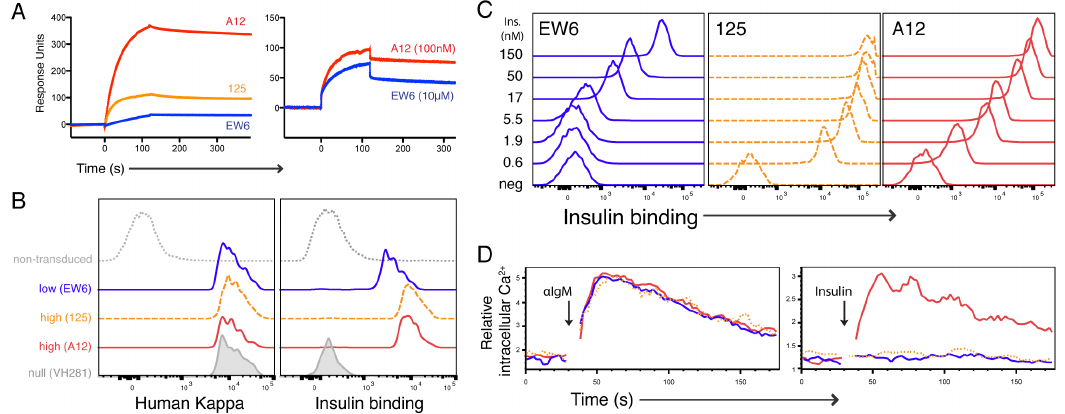
Figure 1. Light chain pairing with VH125 affects affinity for insulin. ( A ) SPR of recombinant Ig at 1 μ M insulin concentration (left); comparison of high ‐ affinity A12 binding 100 nM insulin and low ‐ affinity EW6 binding 10 μ M insulin (right); ( B ) VH125 transgenic bone marrow was transduced with light ‐ chain ‐ encoding retrovirus generating TR ‐ B cells for analysis of BCR functionality in vitro. B220+, GFP+, IgM+ TR ‐ BCR surface expression assessed by staining for human kappa constant region (left). Binding to labeled insulin (~50 nM) by A12, 125, and EW6 compared to GFP ‐ and VH281 + A12 (right). ( C ) Binding equilibria titration performed using multiple dilutions of labeled insulin reveals 125 binds insulin more strongly than A12 when expressed as a BCR; ( D ) TR ‐ B cell [Ca 2+ ] i response to stimulation with 5 μ g/mL anti ‐ IgM (left) or 50 μ g/mL insulin (right): A12 (red), 125 (dashed orange), EW6 (blue). Data are representative of at least three individual experiments.